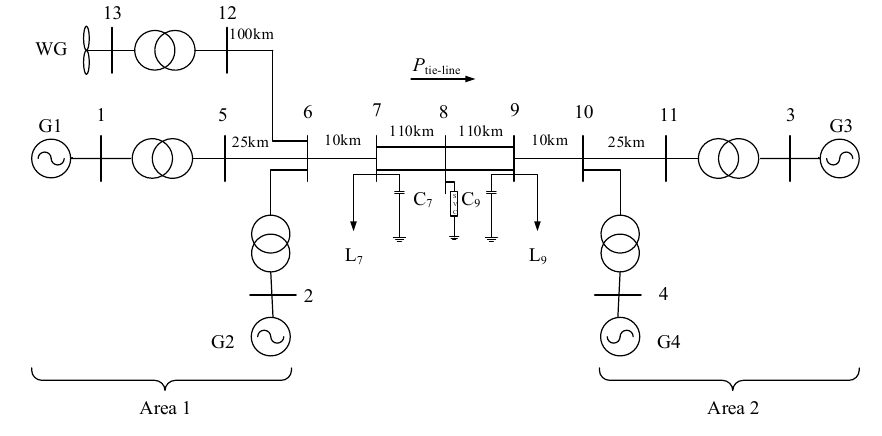
Figure 7. Modified Two-area Kundur test system.